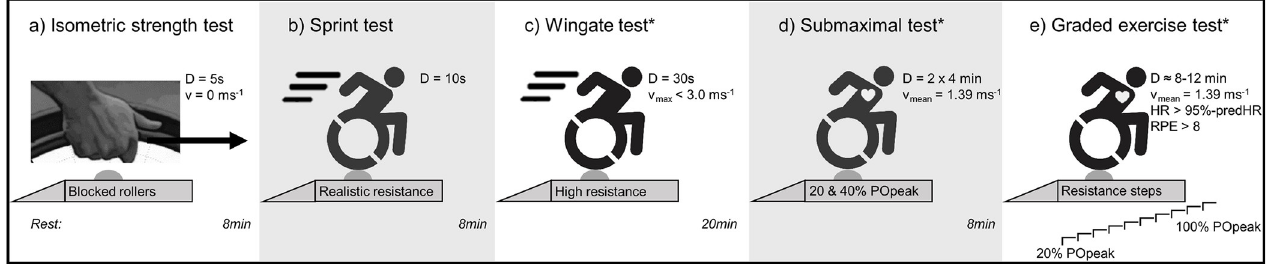
Fig 2. Schematic overview of the experimental protocol. Set-up for the five tests. D = duration, v = velocity, HR = heart rate, RPE = rate of perceived exertion, � = resistance is individually determined.